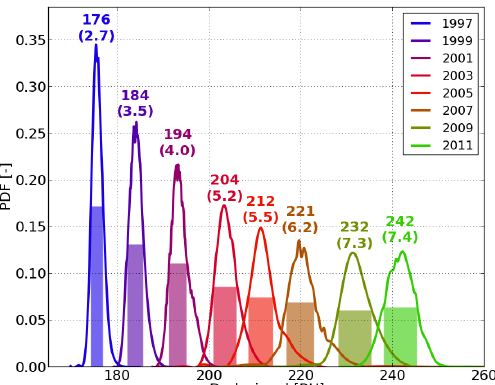
Figure 13. Probability density function (PDF) of the dark signal in spectral band 1a for an integration time of 12s for every 2 years from 1997 to 2011. Coloured numbers denote the median value in binary units (BU) and the FWHM (in parenthesis) of the distribu- tion. The latter is additionally indicated by the coloured